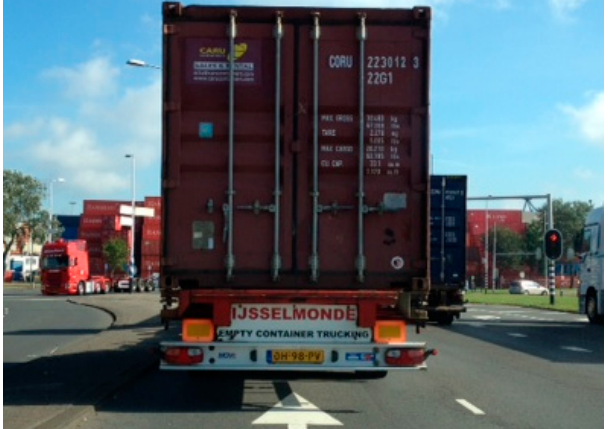
Figure 13. Empty container trucking. Reproduced with permission from [42].